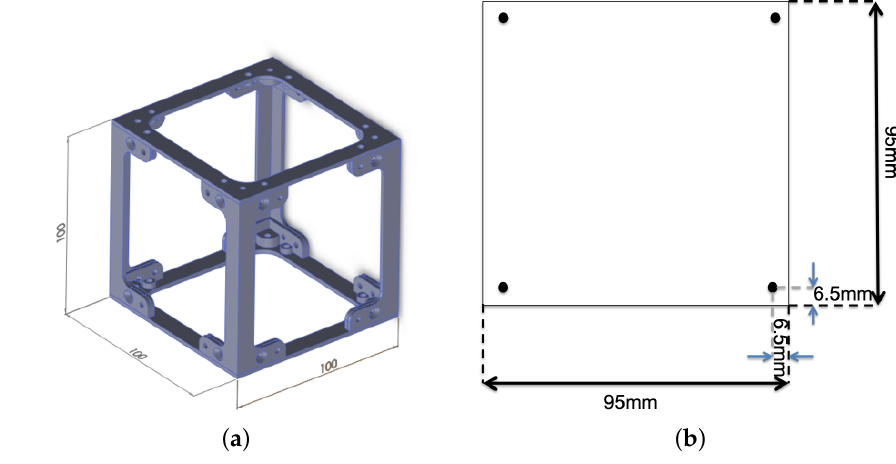
Figure 3. Structure and PCB measurements in mm. ( a ) CubeSat structure. ( b ) PCB